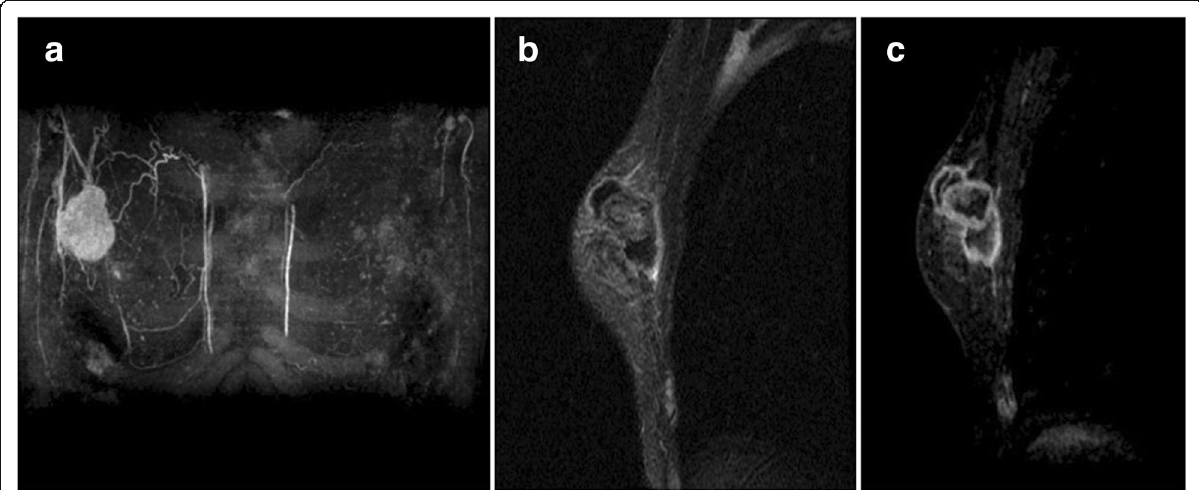
Fig. 3 Magnetic resonance imaging. a A 4.5-cm-diameter mass at the upper outer portion of the right breast. b Fat suppression (FS) T2-weighted imaging (WI): A high signal intensity at the periphery and center of the tumor. c Gadolinium (Gd) FS T1WI: A high signal intensity at the periphery of the tumor but a low signal intensity in the central area